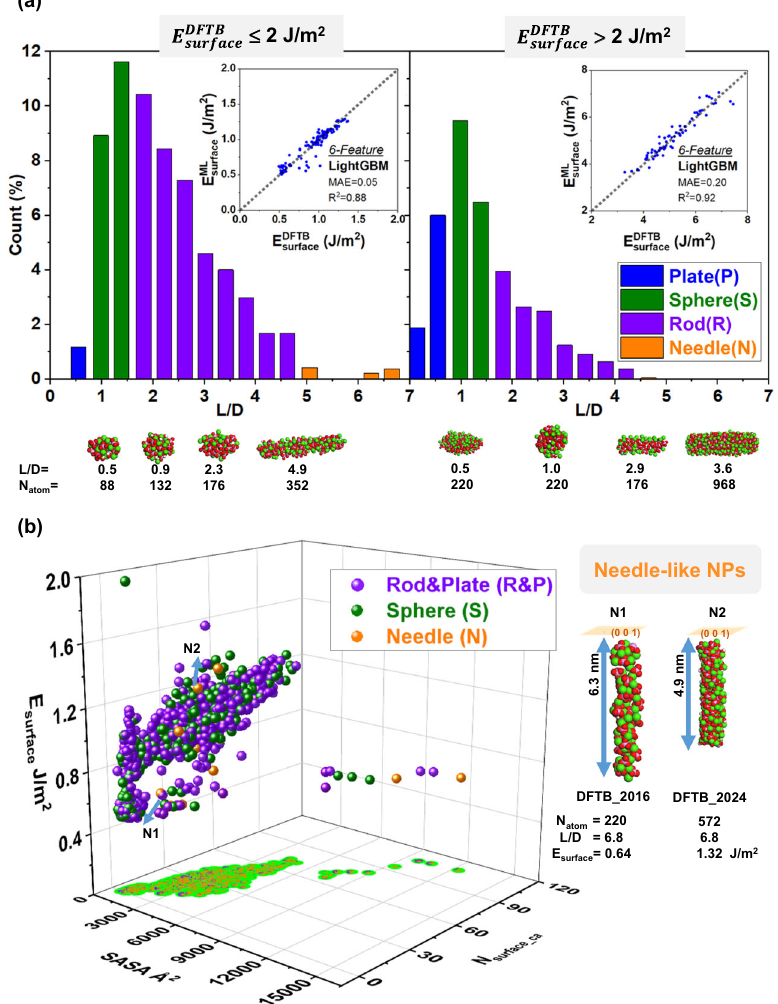
Fig. 4 Morphology and surface energy of HANPs on DFTB dataset. a Morphology and length diameter ratio, L / D ratio, distribution of stable and meta-stable structures. b The relationship between SASA, coordination number of surface calcium, and surface energy, along with two typical needle-like HANPs with low surface energy and growing direction toward (0 0 1)